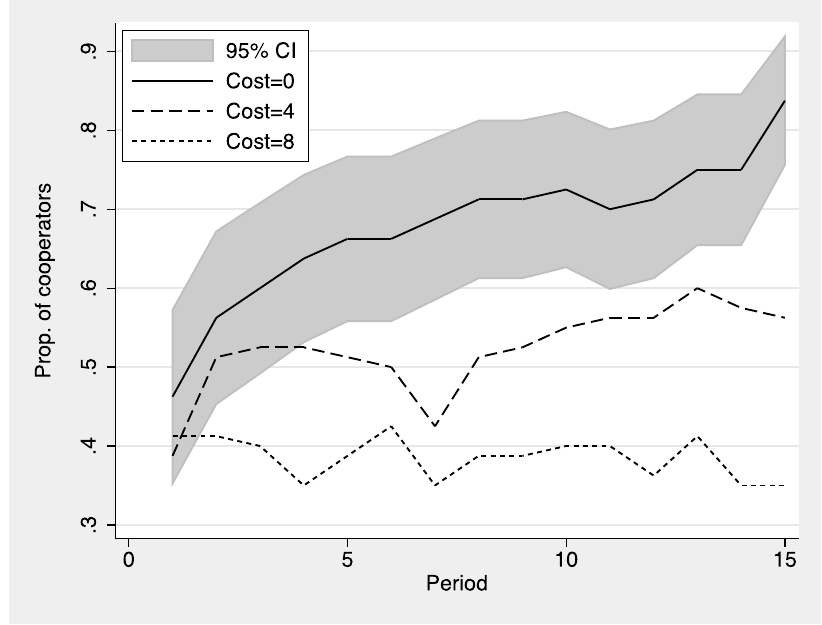
Figure 2. Fraction of cooperators by period and treatment (cost of information). Cooperation starts at just below 50% in all treatments. Cooperation rapidly increases over periods in the treatment with free information on potential partners’ actions. Cooperation builds up less rapidly in the low-cost (Cost=4) treatment and remains almost at the initial level for the high cost (Cost=8) treatment. The grey area plots the 95% CI for the Cost=0 treatment.